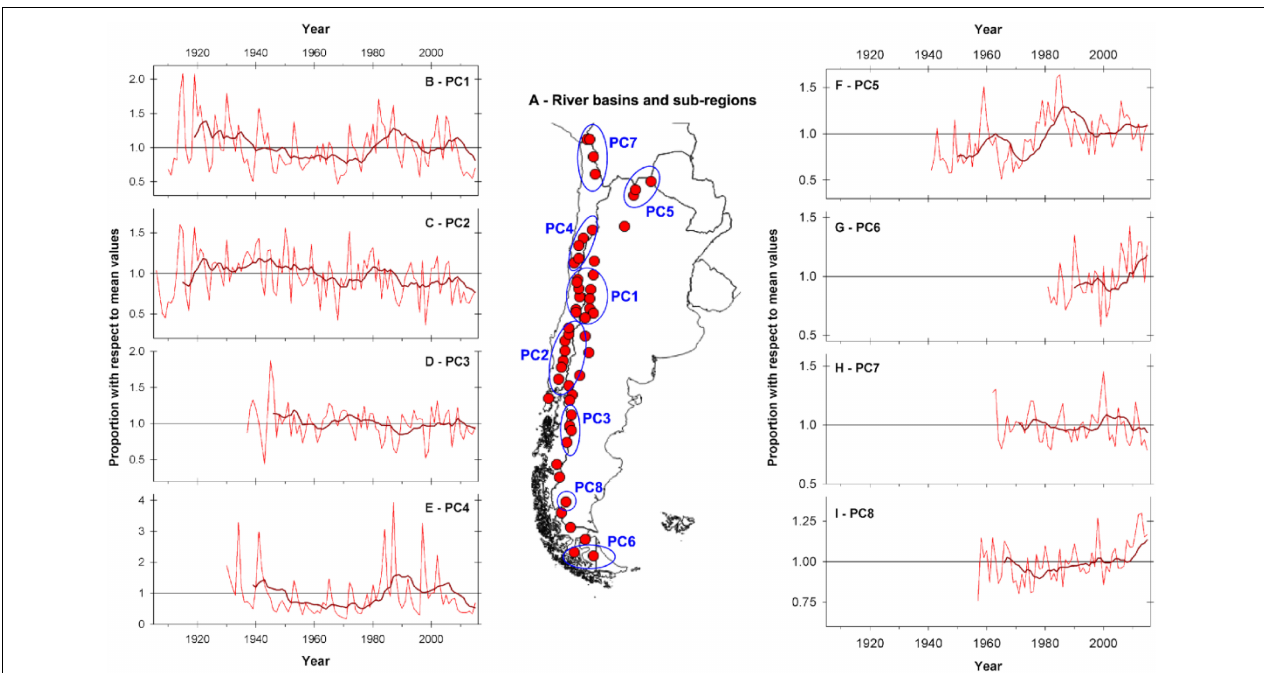
FIGURE 4 | (A) Map showing the location of the selected river basins used to identify the main regional patterns of streamflow variations in the subtropical and extratropical Andes (18–55 ◦ S). (B) Mean annual (April–March) regionally averaged streamflow record for the PC1 sub-region (thin red line). Ten-year moving averages (thick red line) are also shown to highlight the lower frequency variations in this record. (C–I) Same as (B) , but for PC2 trough PC8, respectively. See Masiokas et al. (2019) for